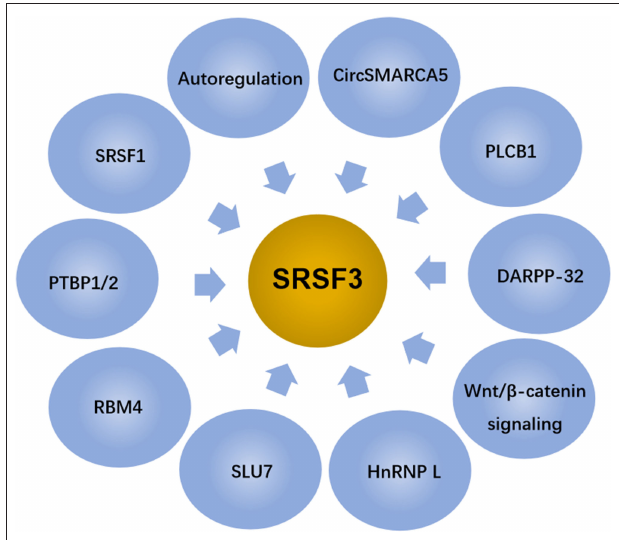
FIGURE 3 | SRSF3 expression is regulated by several factors and signaling